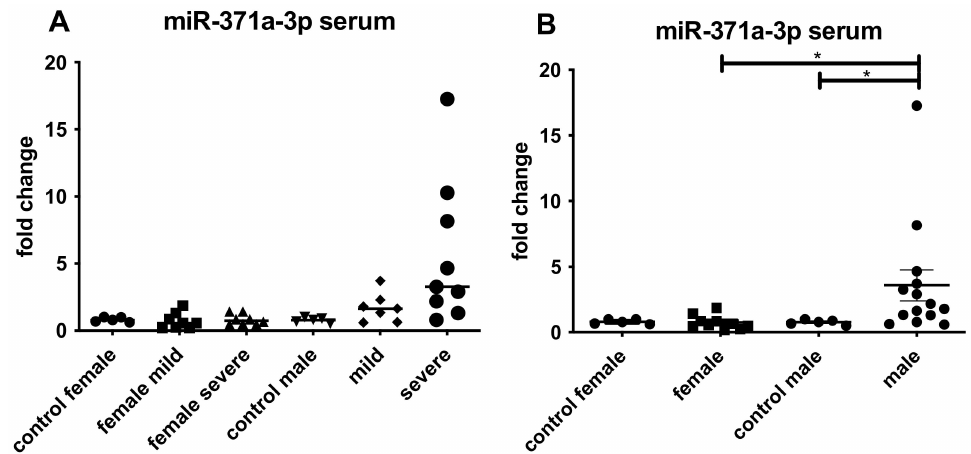
Figure 5. qRT-PCR results for the detection of miR-371a-3p in serum from patients with mild or severe COVID-19. ( A ) depicted the miR-371a-3p expression female and male. Upregulation was found in case of male patients either with mild or severe symptoms. ( B ) summarized all female and male cases showing the expression of the miR-371a-3p. Increase in male patients was detectable (* p <